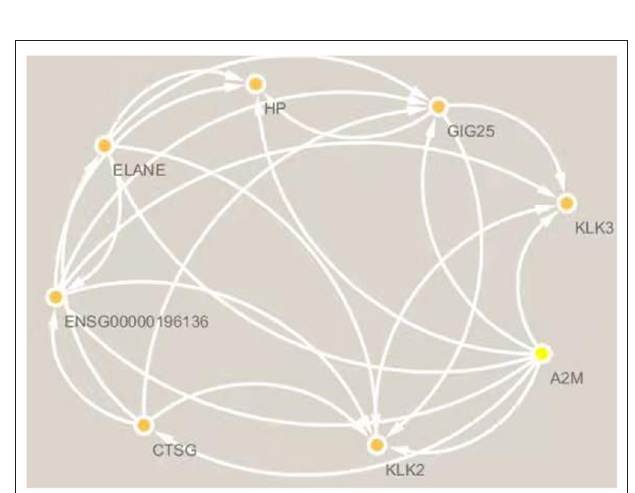
FIGURE 3 | Clustering module 1 scored 6.571 and had 8 nodes and 23 edges. The hub gene is ELANE